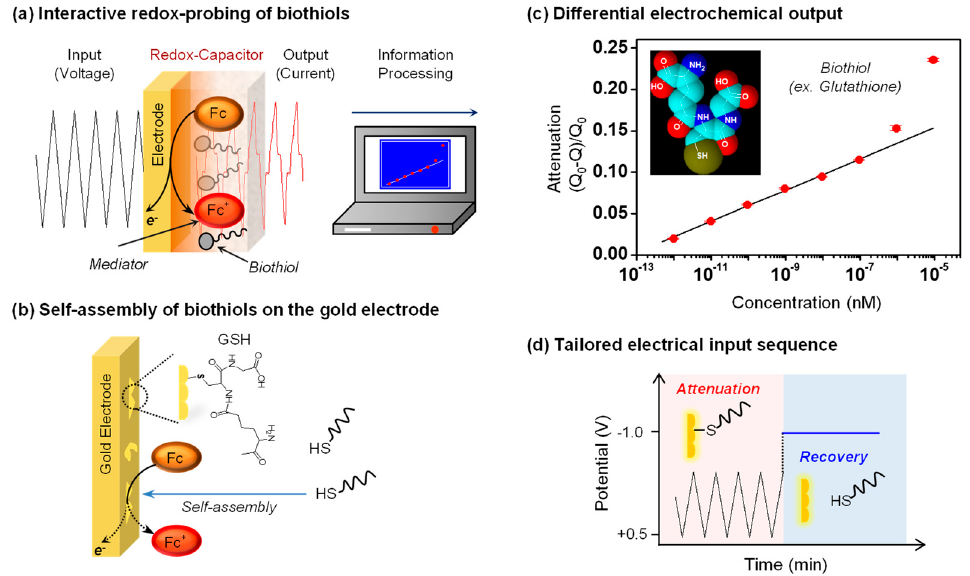
Figure 6. Interactive redox-probing of biothiols. ( a ) The electrochemical information processing approach allows the acquisition of chemical information of biothiols. ( b ) Thiols can self-assemble on gold and potentially attenuate electrochemical signals. ( c ) The quantitative analysis of signal attenuation could be correlated to glutathione (GSH) concentration. Q: Ferrocene dimethanol (Fc)-oxidative charge with biothiol; Q 0 : Fc-oxidative charge without biothiol. ( d ) Tailored electrical input sequence to test the hypothesis that GSH self-assembly on gold attenuates Fc-oxidation. Adapted with permission from [27]. Copyright (2016) American Chemical Society.